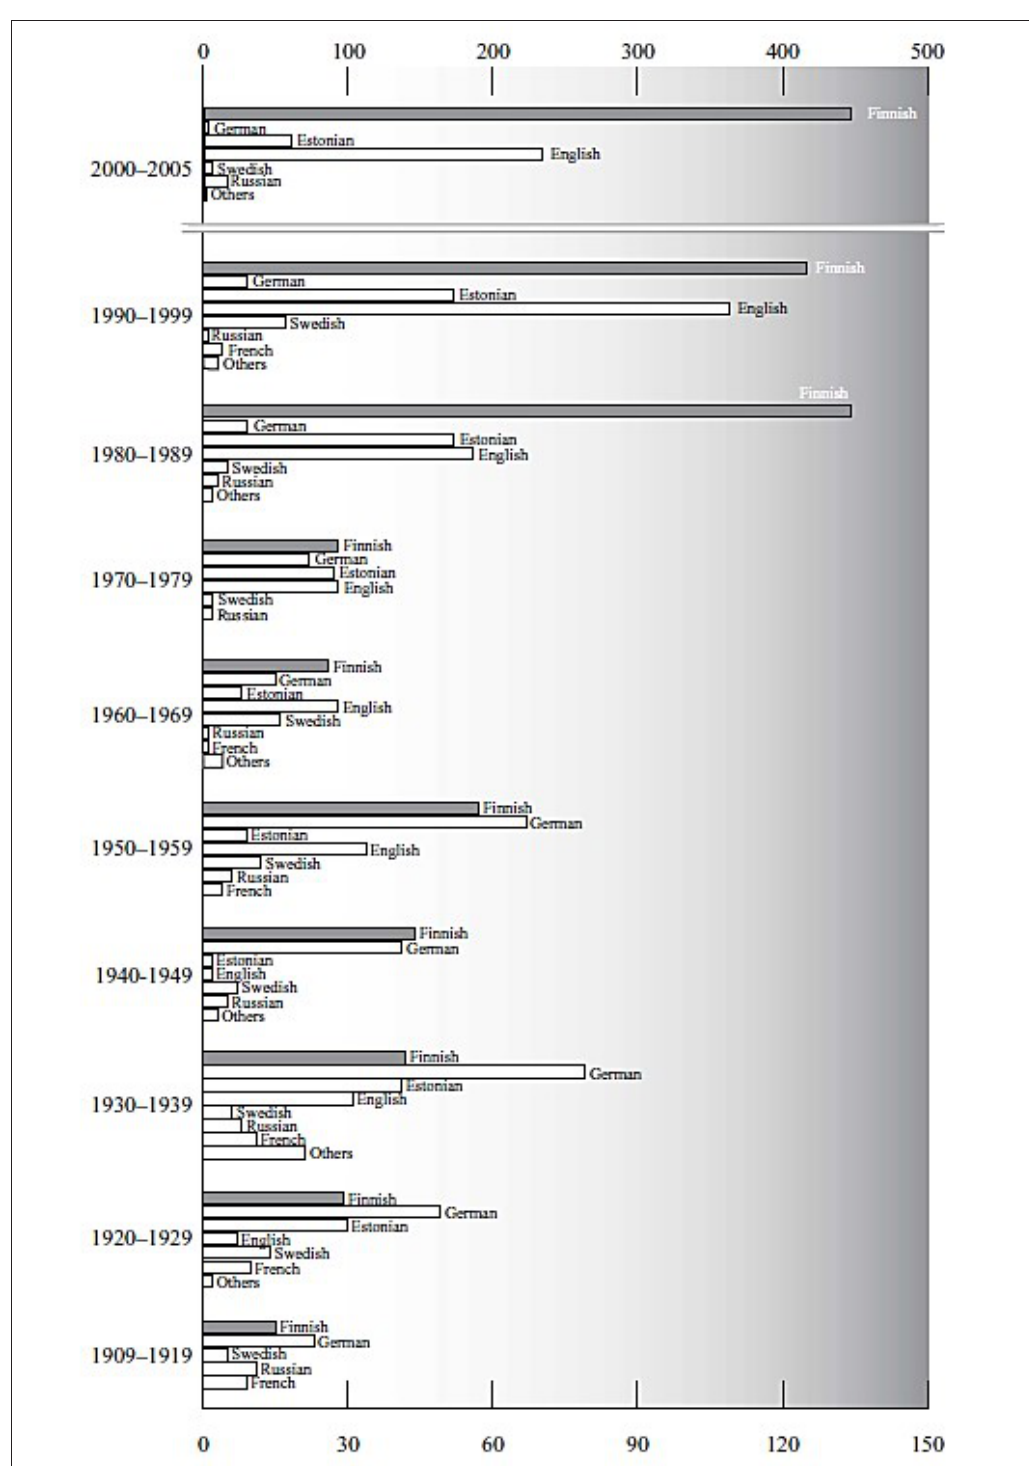
Figure 8: Statistics of references to publications of J. G. Granö (Granö,